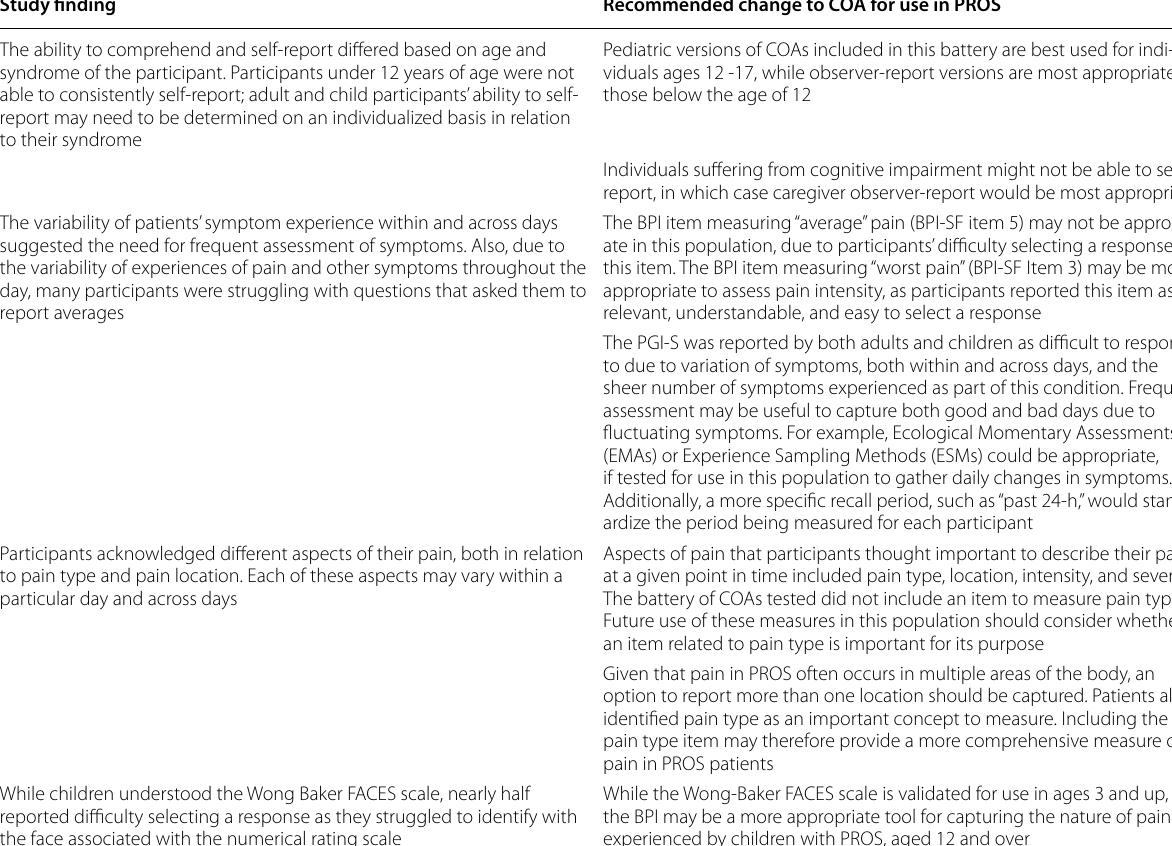
Table 5 Recommended changes of tested COAs for use in a PROS population Study finding Recommended change to COA for use in